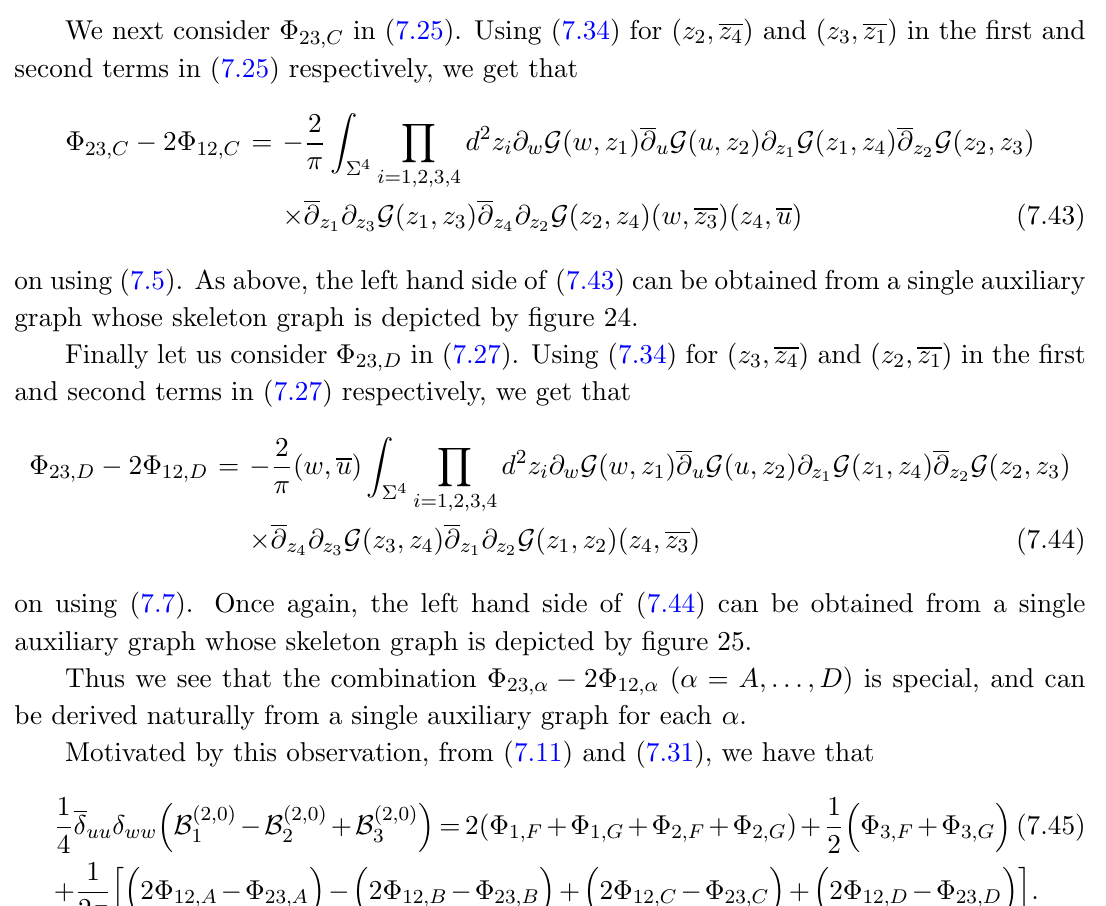
Figure 24 . Skeleton graph for (cid:8) 23 ;C (cid:0) 2(cid:8) 12 ;C